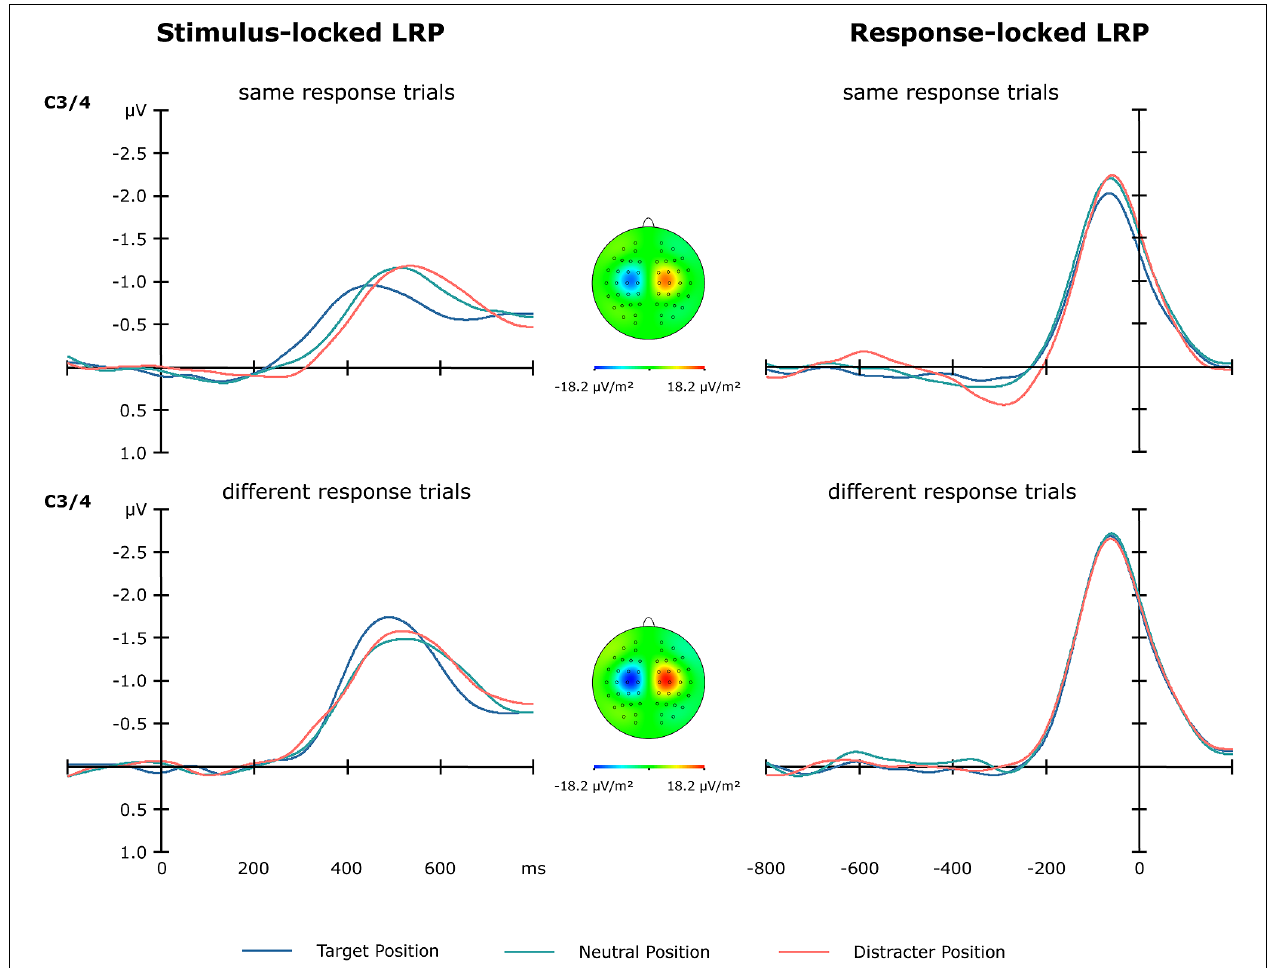
FIGURE 5 | Lateralized readiness potentials obtained from electrodes C3/4 as a function of target position sequence (blue line: target at previous target location, green line: at previous neutral location, red line: at previous distractor location) and motor-response sequence (same vs.